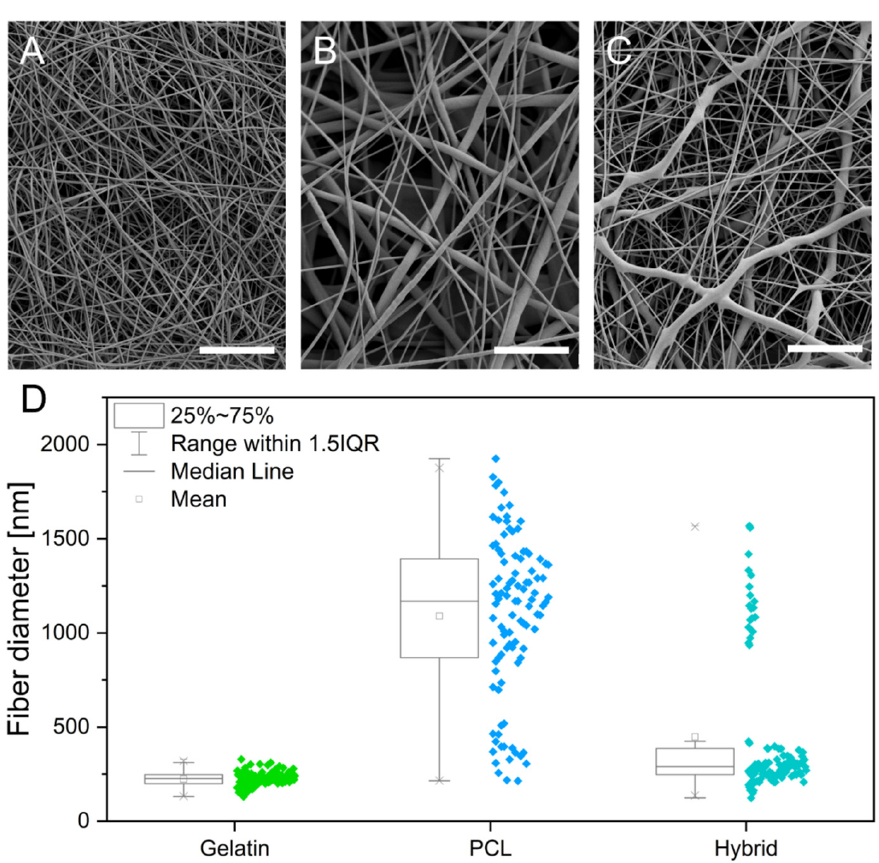
Figure 1. ( A – C ) Scanning electron micrographs of electrospun gelatin ( A ), PCL ( B ), and hybrid ( C ) scaffolds. ( D ) Box whisker plots showing the fiber diameter distribution in gelatin, PCL, and hybrid scaffolds. Scale bars represent 10 µm.